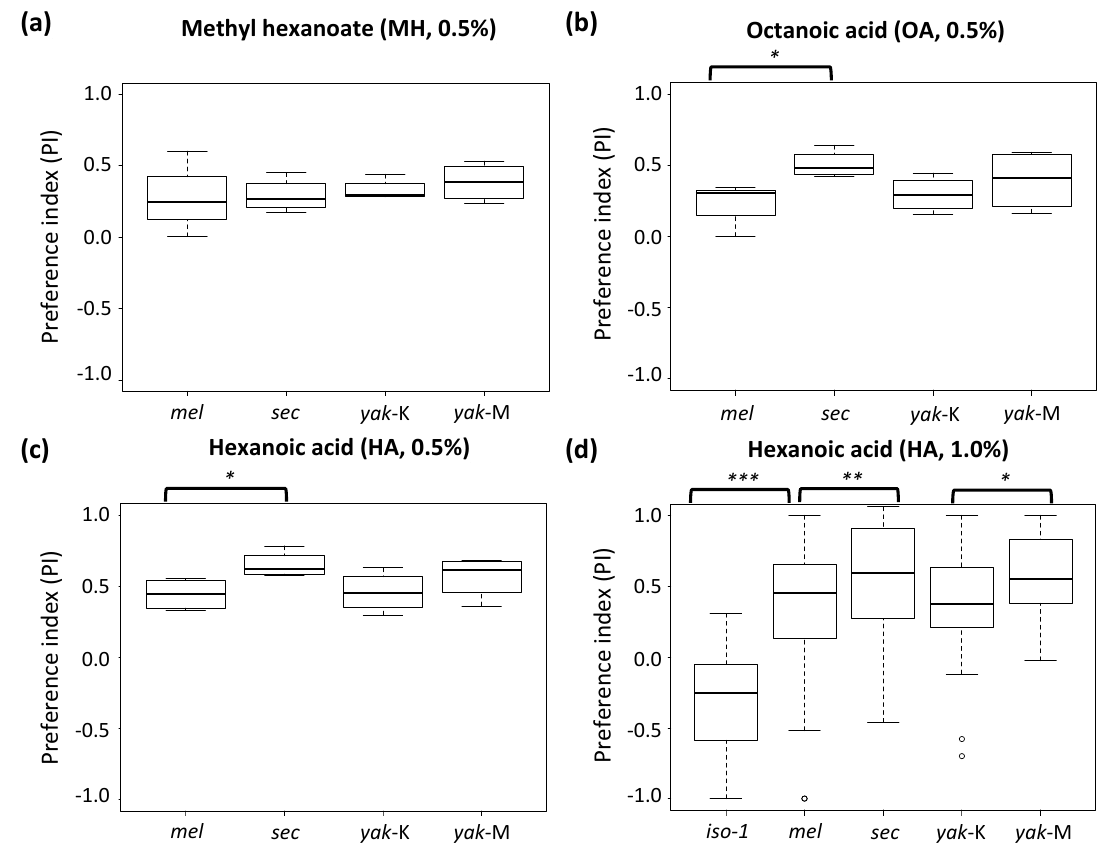
Figure 3. Preference indices of the feeding behavior assays for ( a ) methyl hexanoate at 0.5%, ( b ) octanoic acid at 0.5%, and ( c ) hexanoic acid at 0.5% and ( d ) 1.0%. Strain names are abbreviated as: mel = D. melanogaster from Mt Oku, iso-1 = D. melanogaster strain mutant for Gr22b and Gr22d , sec = D. sechellia , yak -K = D. yakuba yakuba from Kunden and yak -M from D. y. mayottensis . p -values are indicated as: * < 0.05, ** < 0.01 and *** < 0.001.